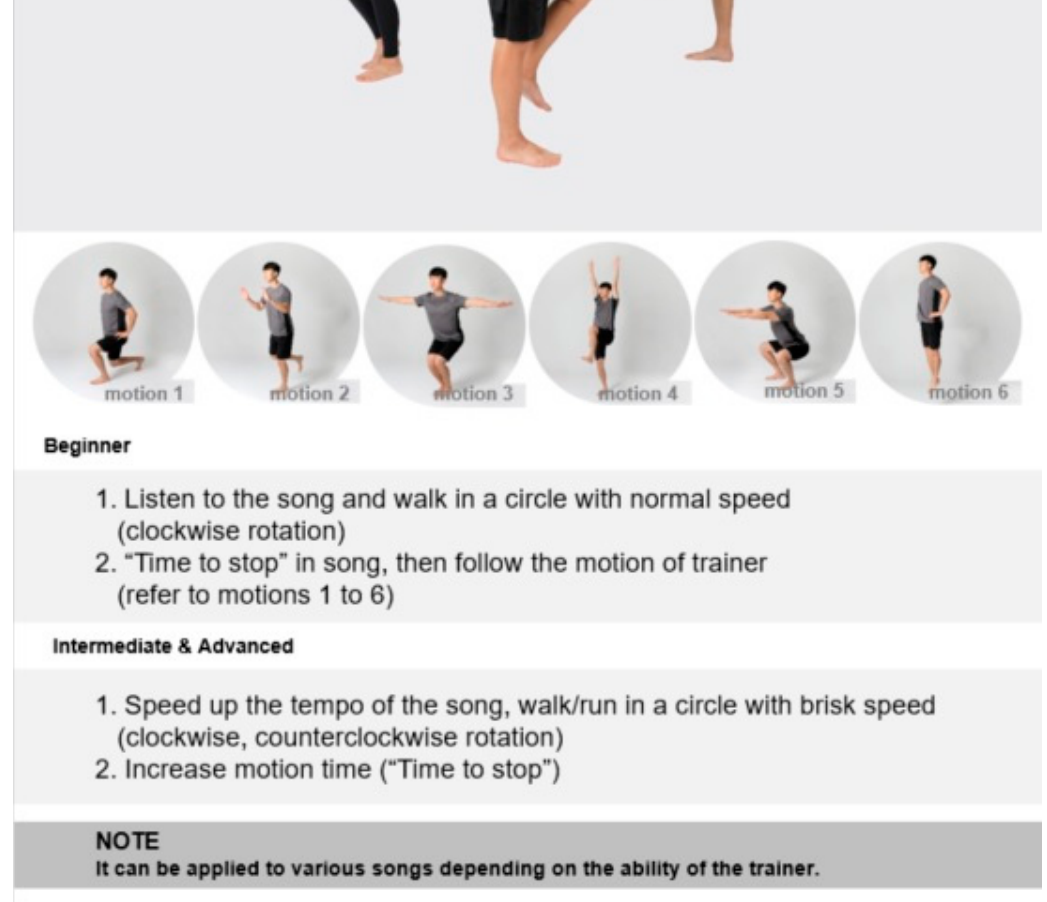
Figure A4. Detailed description and components of each movement in the “Time to stop” aerobic exercise.